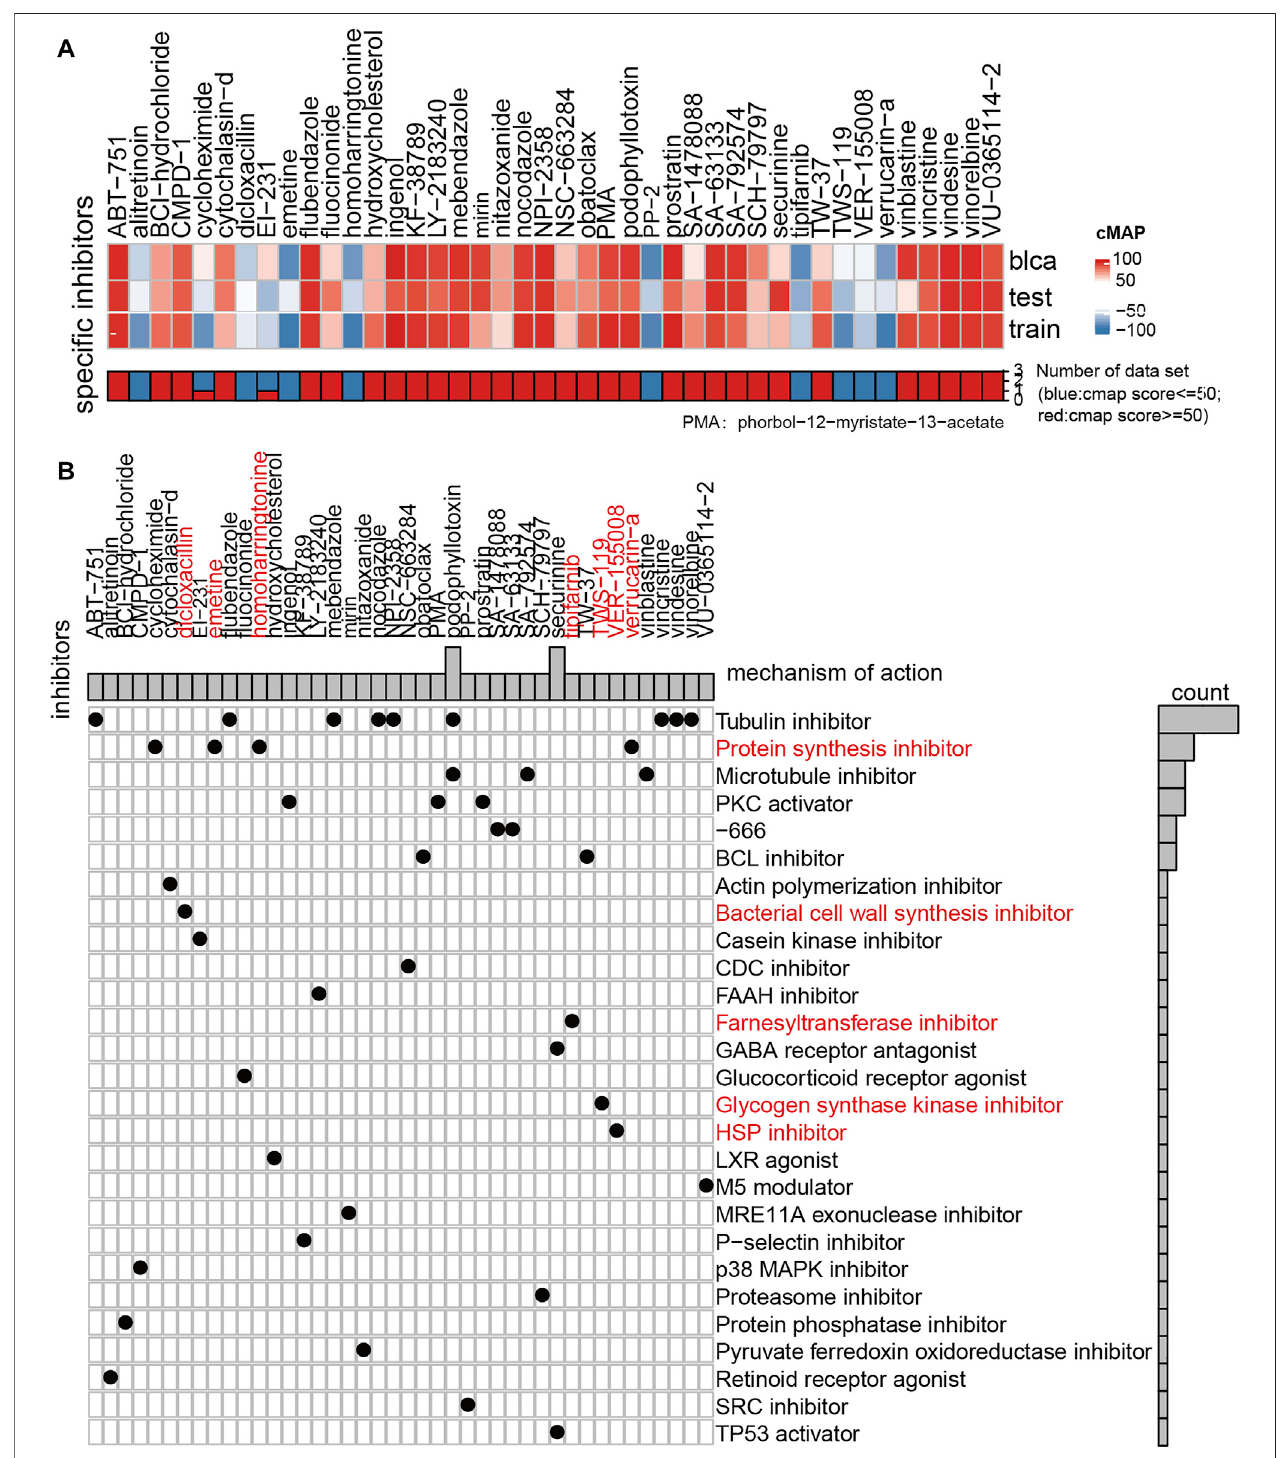
FIGURE 7 | Results of drug sensitivity analysis of GDSC and CMAP. (A) Thermogram showed the small molecule drugs in the CMAP analysis results. Blue means that the cell expression pro fi le treated with the small molecule drugs has similar effect with the low hypoxia score subgroup, and red represents that the effect of the cell expression pro fi le treatedwith thesmall moleculedrugs issimilar tothat ofthehigh hypoxia score subgroup (|score| > (cid:1) 60). (B) The drugmolecularmechanism ofsmall molecule drugs according to the above CMAP results.